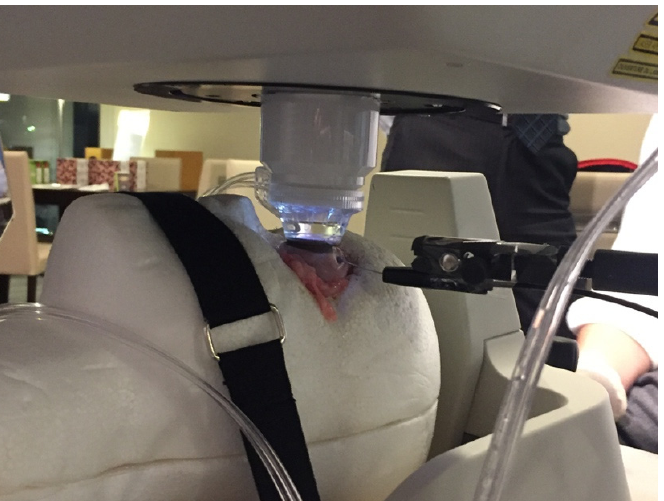
Figure 1. Eyeballs were placed on custom-made stands in order to achieve an appropriate height and position for femtosecond laser system CATALYS for the purpose of connecting the liquid optic interface and endoscope to the porcine eye.